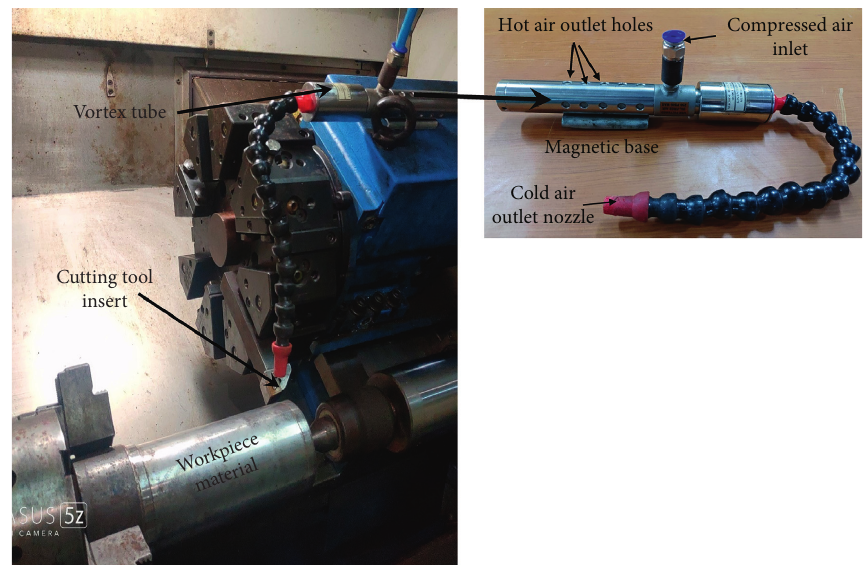
Figure 2: Experimental setup of Compressed Chilled Air by Vortex Tube.